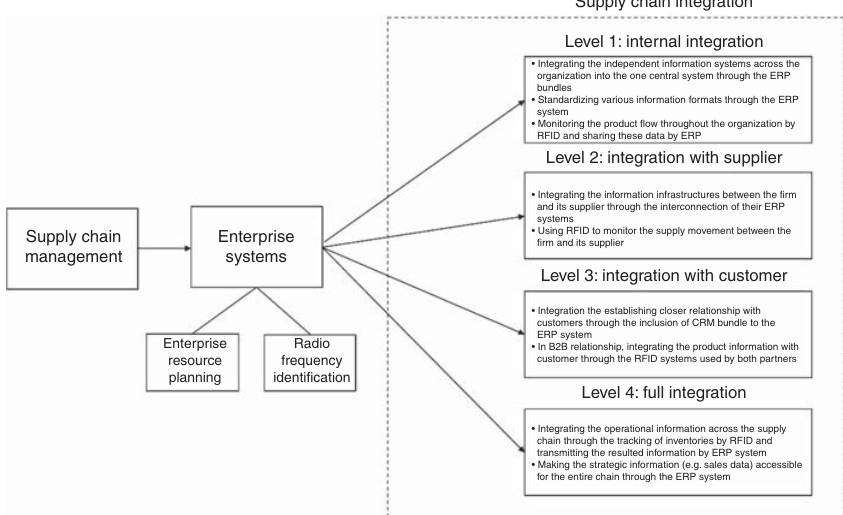
Figure 1. Proposed conceptual